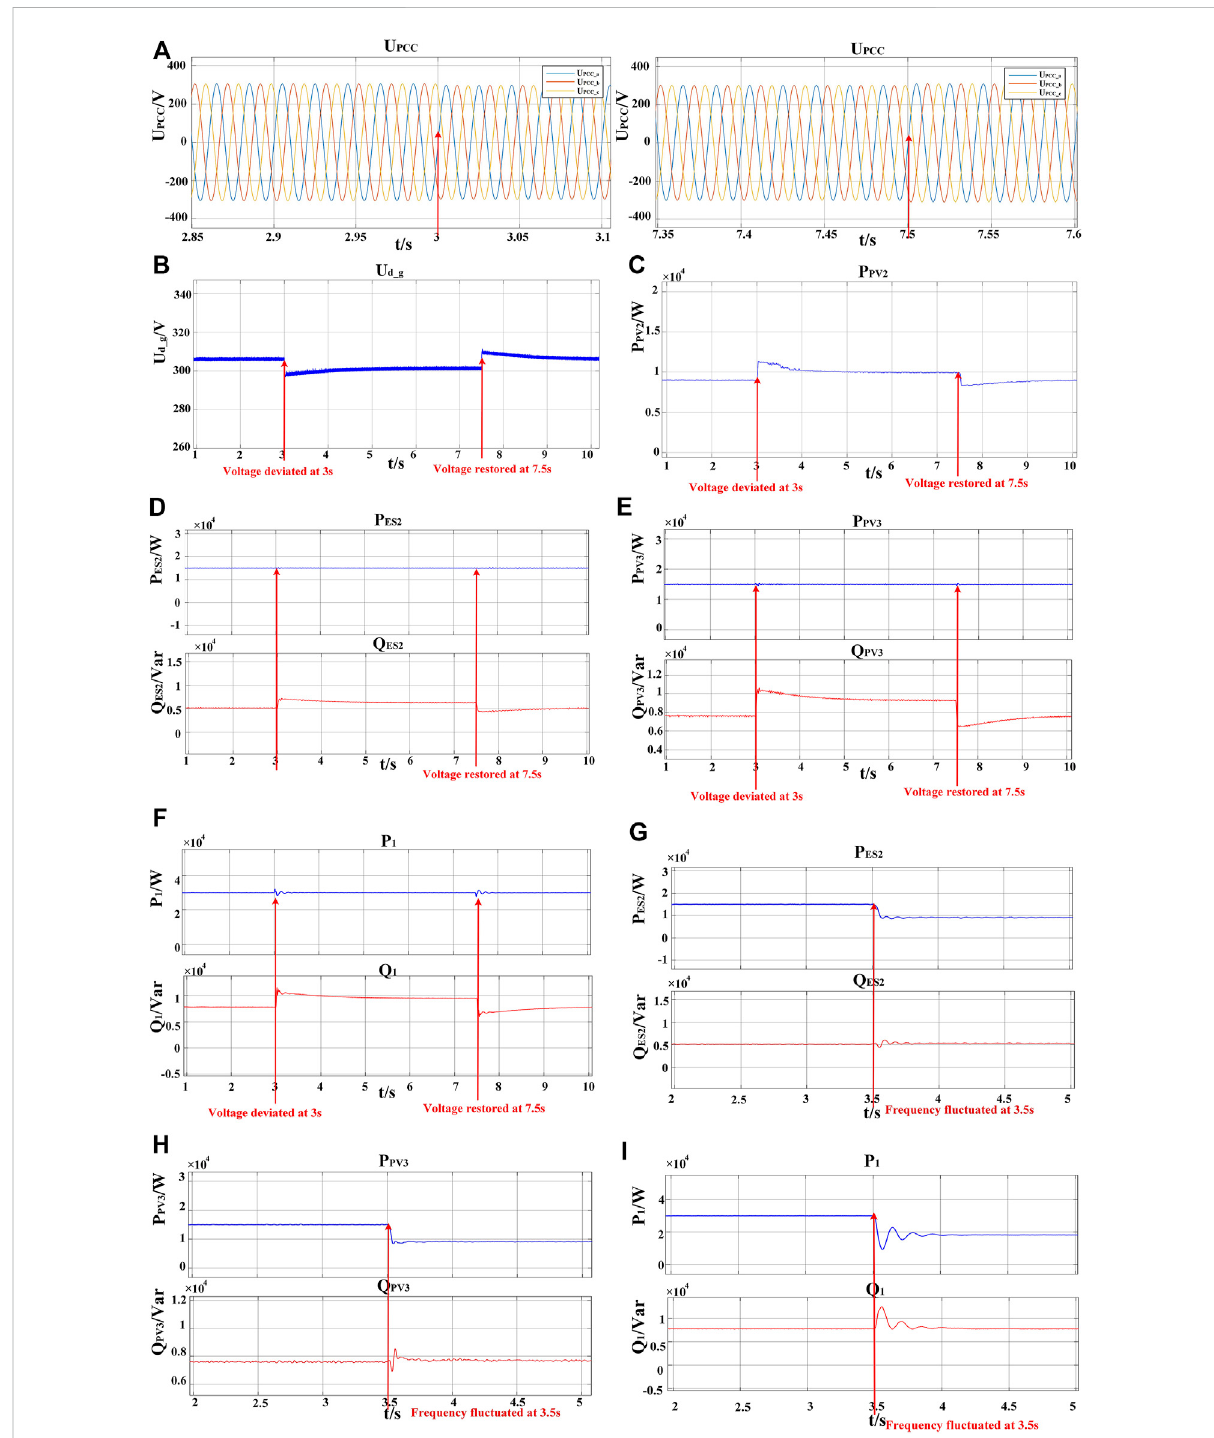
FIGURE 11 TheoutputoftheDGsintheprosumeringrid- fl uctuationmode: (A) ThevoltageinPCC; (B) TheamplitudeofthevoltageinPCC; (C) Theoutput active power of PV2; (D) The output active power and reactive power of ES2; (E) The output active power and reactive power of PV3; (F) The output active power and reactive power of theintegrated inverter; (G) The output active power and reactive power of ES2; (H) The output active power and reactive power of PV3; (I) The output active power and reactive power of the integrated